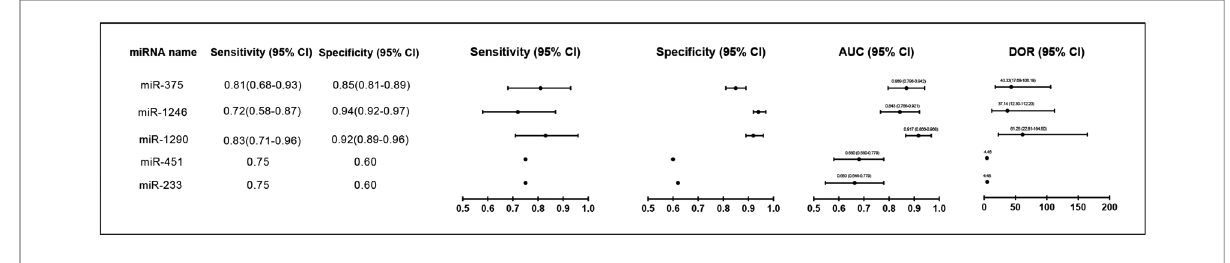
Figure 5 Forest plot of miRNAs levels as biomarkers for diagnosis of NEC patients in different studies. AUC, Area Under Curve; DOR, diagnostic odds ratio; 95% CI, 95% con fi dence